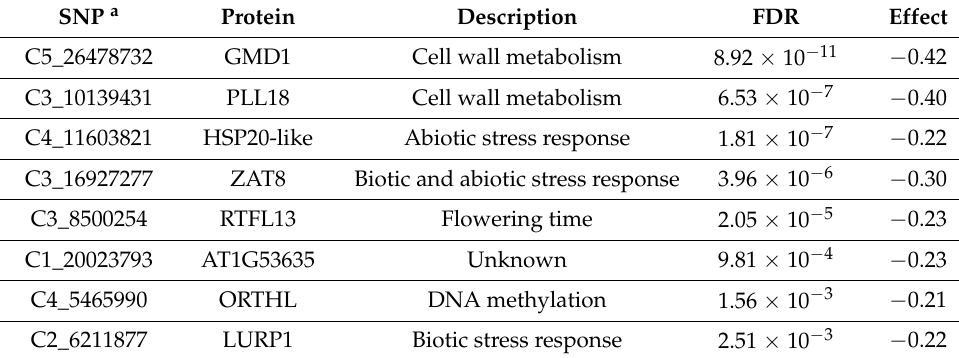
Table 1. SNPs significantly associated with virulence according to FDR threshold.